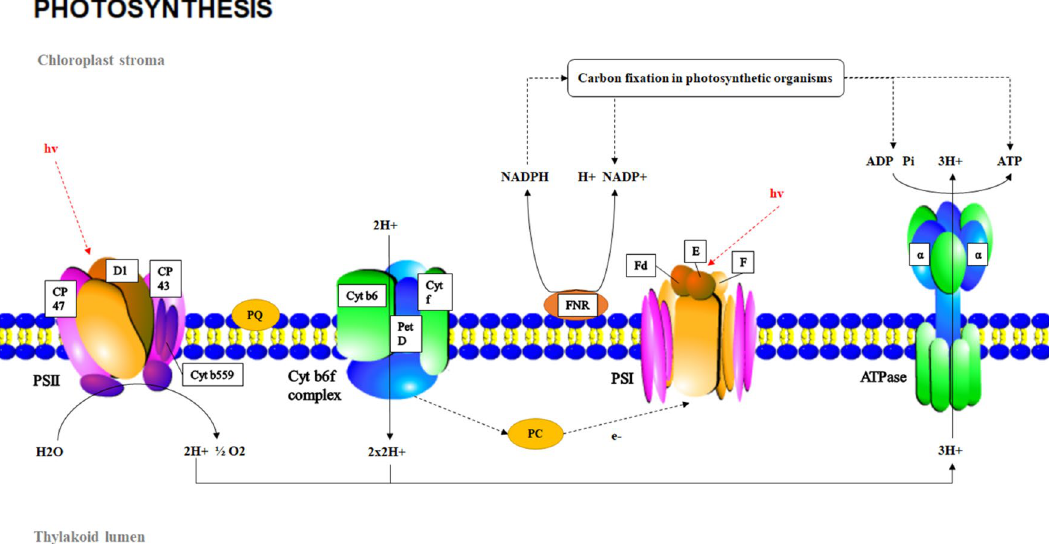
Figure 9. Photosynthesis of A. mongolicus under low-temperature stress. The areas outlined by white boxes indicate the differentially expressed genes in these